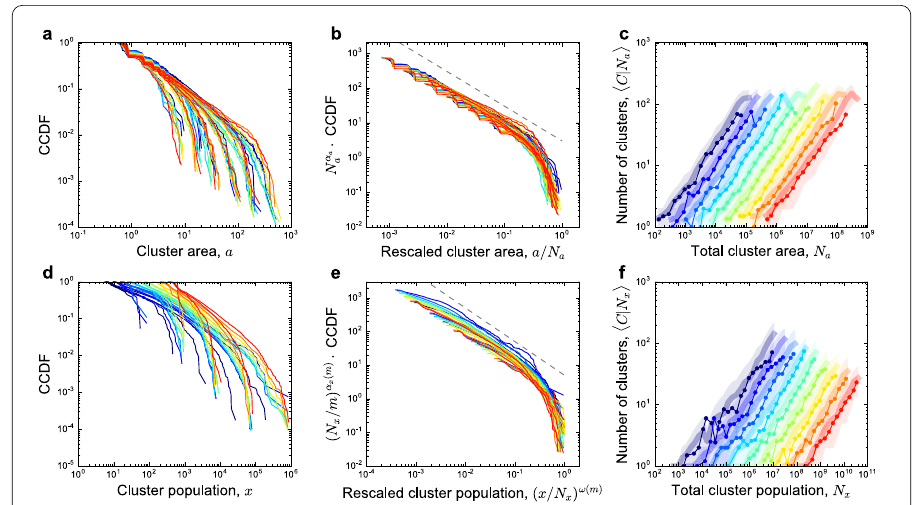
Figure 5 Zipf’s law and Heaps’ law for urban clusters. ( a ), Counter Cumulative Distribution Functions of areas of the clusters in all United States regions of 128 × 128 km 2 having urbanised area up to 5%. Regions are grouped in six groups according to their total urbanised area, N a , and the CCDFs of each group are computed separately for the different values of the CCA parameter m (see the legend in Fig. 4(f) for the m values). ( b ), The CCDFs of panel ( a ) collapse on the same curve when the axes are properly rescaled. The dashed grey line is a power law with exponent –1 as a guide for the eye. ( c ), Average number of clusters as a function of the total urbanised area, N a , for the 128 × 128 km 2 United States regions (circles). The lower and upper values of the dashed areas denote the 10th and 90th percentile of 100 realisations of the null model. For clarity, curves have been shifted by m 2 along the x -axis. ( d ), Counter Cumulative Distribution Functions of populations of the clusters in all United States regions of 128 × 128 km 2 having urbanised area up to 5%. Regions are grouped in six groups according to their total population, N x , and the CCDFs of each group are computed separately for the different values of the CCA parameter m . ( e ), The CCDFs of panel ( d ) collapse on the same curve when the axes are properly rescaled. The dashed grey line is a power law with exponent –1 as a guide for the eye. ( f ), Average number of clusters as a function of the total population, N x , for the 128 × 128 km 2 United States regions (circles). The lower and upper values of the dashed areas denote the 10th and 90th percentile of 100 realisations of the null model. For clarity, curves have been shifted by m 2 along the x